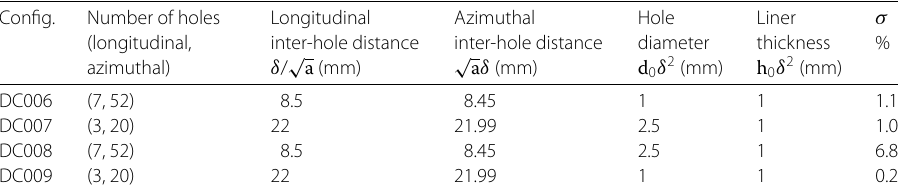
Table 1 Liner configurations. The length of the liner is L = 60 mm. The value of the viscosity is ν ( δ ) = 1.4660 × 10 –5 m 2 /s. For all these configurations b = 0.5